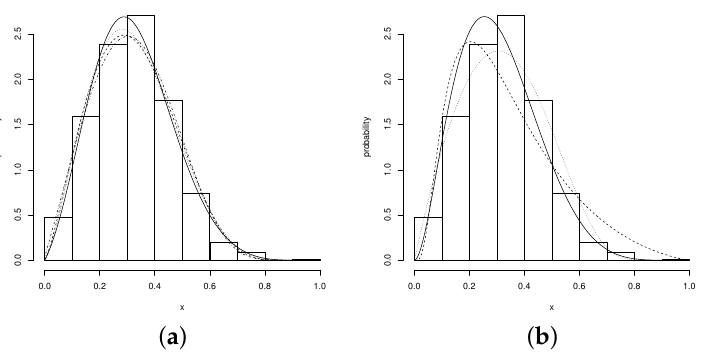
Figure 3. Fitted distributions ( a ) UPSN (solid line), USN (dotted line), UPN (dashed line) and UN (dashed and dotted line), ( b ) Beta (solid line), UW (dotted line) and UBS (dashed line). Table 4. PDF of the distribution fitted to